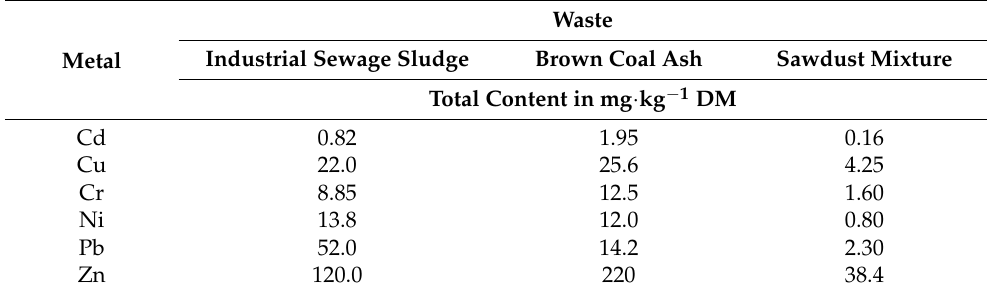
Table 1. Content of heavy metals in waste used for the production of fertilizer granulates.